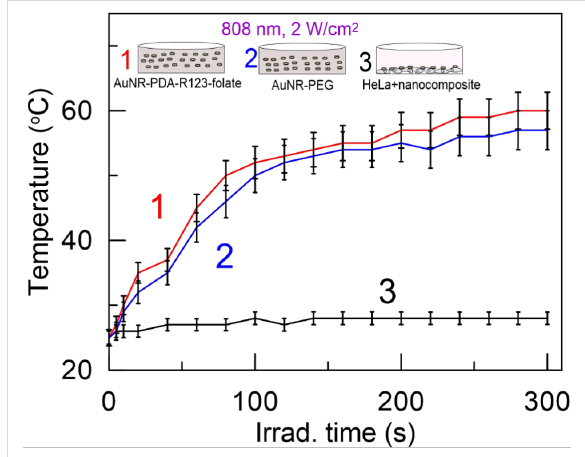
Figure 3: Temperature changes of AuNR-PDA-R123-folate (curve 1), AuNR-PEG (curve 2) solutions, and well with adhered HeLa cells (curve 3) incubated with AuNR-PDA-R123-folate in response to irradia- tion of a NIR laser (808 nm) with a power density of 2 W/cm 2 .